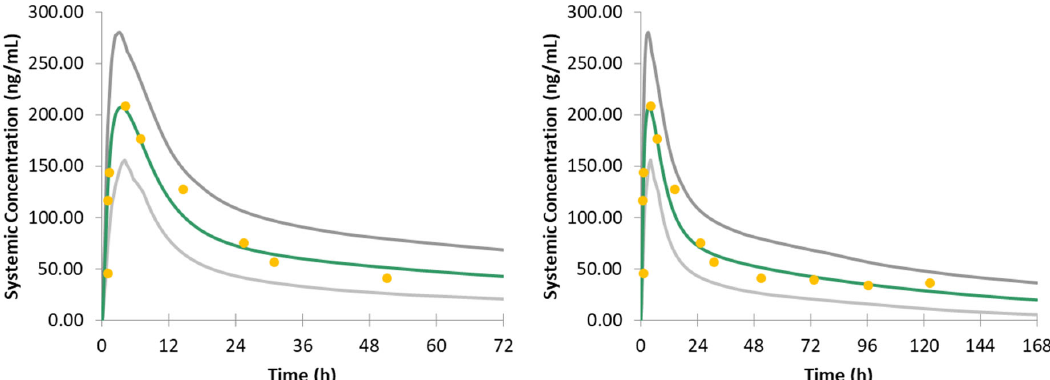
Figure 1. Validation of HCQ model within 3 days ( left ) and 7 days ( right ). The green curve represents the mean value of the simulated virtual subjects, and the grey curves represent the 90% confidence interval. The yellow dots represent the clinical reported 200 mg HCQ PK data.